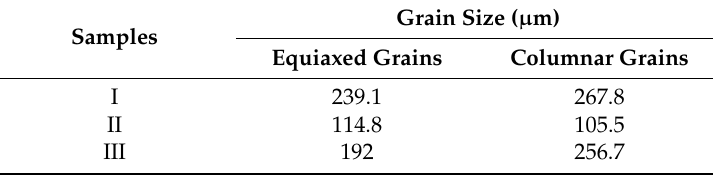
Table 4. Size of columnar and equiaxed grains: I (CC 0.2 m/min), II (CC 0.3 m/min), and III (PC 0.2 m/min).